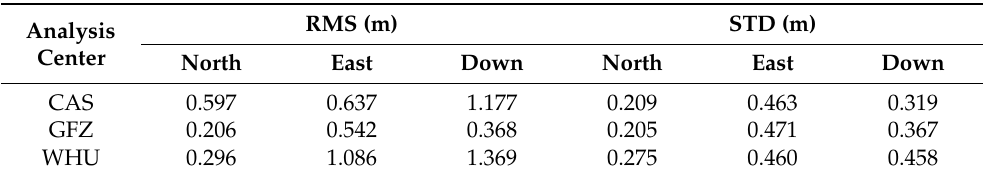
Table 5. Position RMS and STD in the three directions of SF-PPP/INS tight integration using real-time products from CAS, GFZ, and WHU.